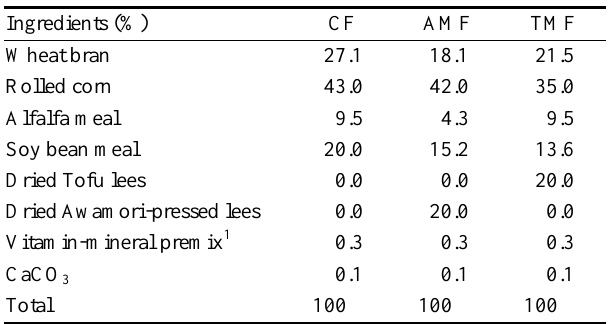
Table 1. Chemical composition of dried Awamori-pressed lees and dried Tofu lees